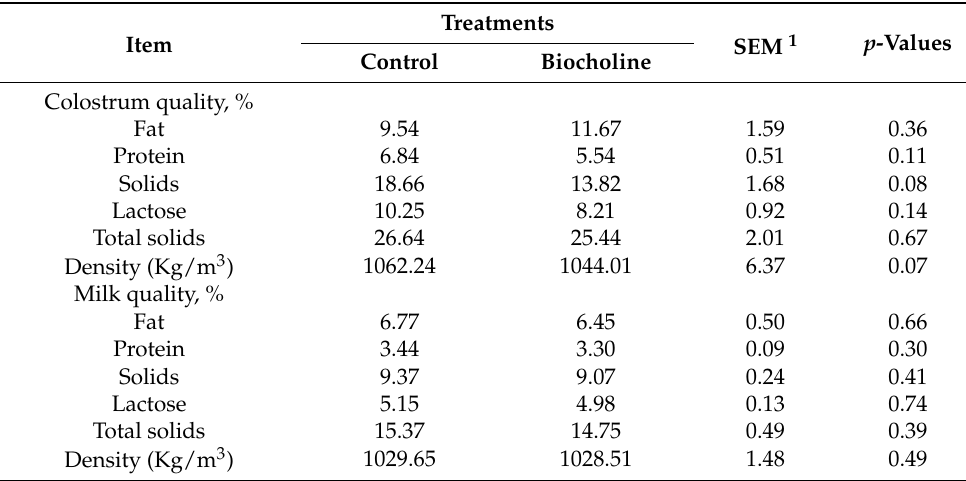
Table 2. Effect on the quality of colostrum and milk from ewes supplemented with an herbal mix as a source of choline during early